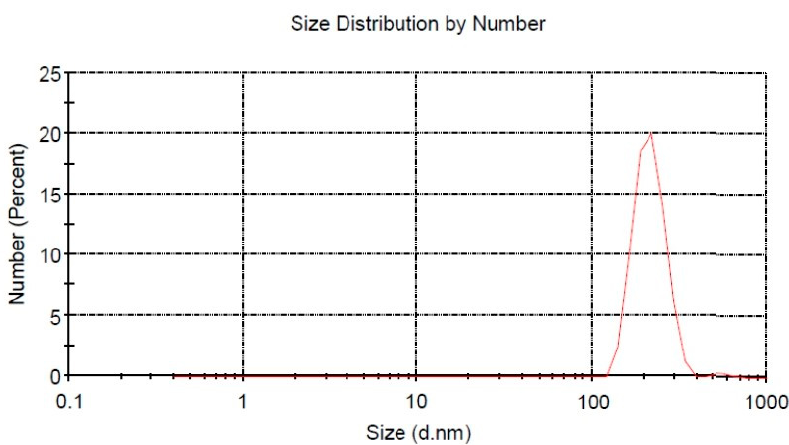
Figure 1. Fucoidan nanoparticle size distribution.